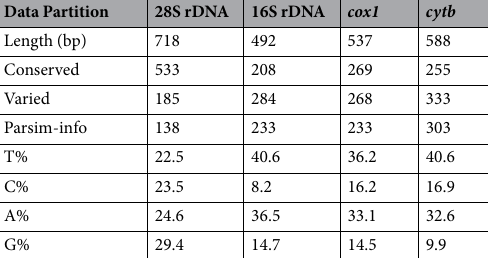
Table 1. Descriptive statistics for data